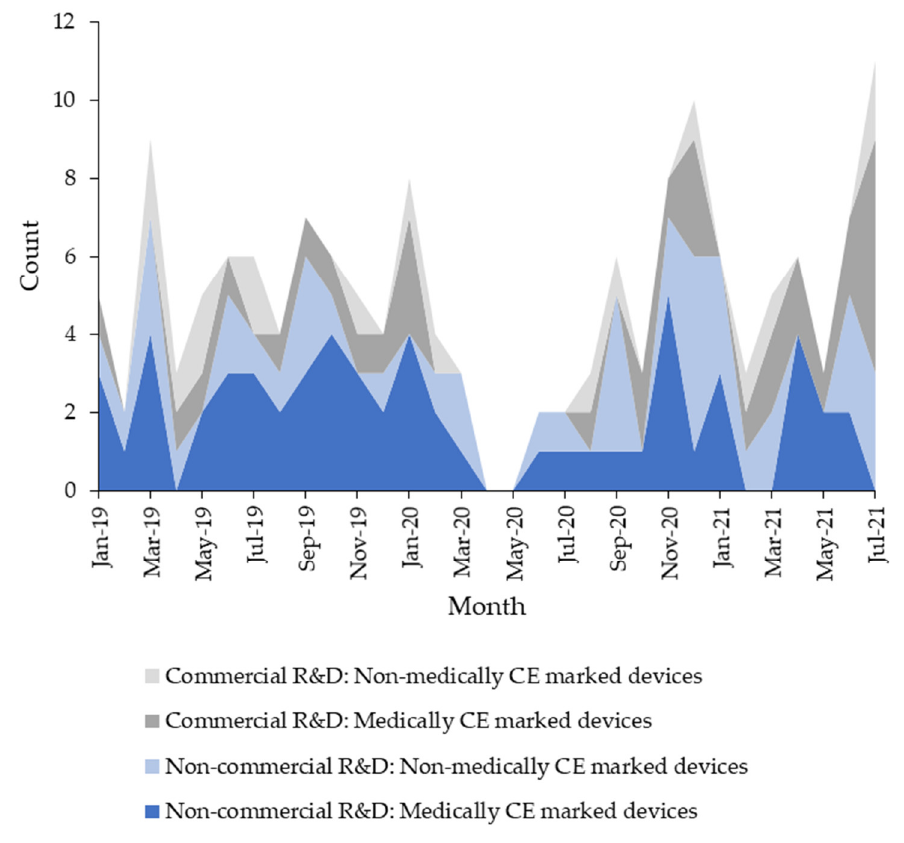
Figure 1. Volume of research studies involving medical devices assessed by GSTFT received in 2019–2021.